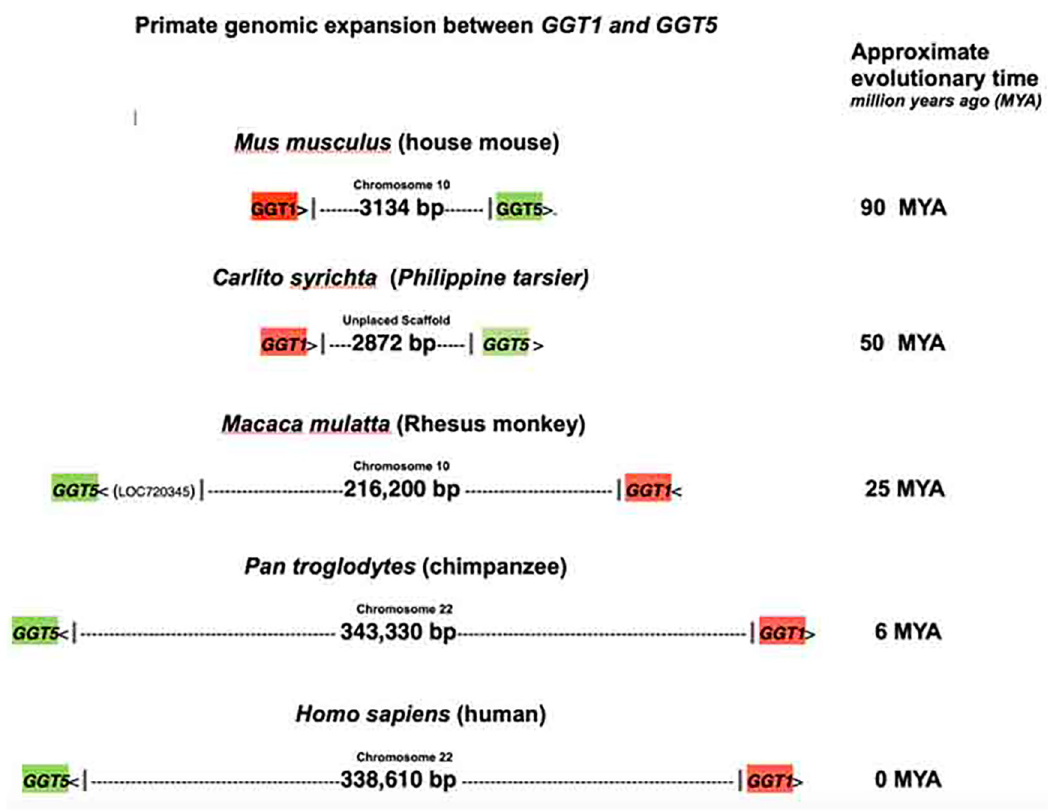
Fig 1. The spacer region/genomic lengths between GGT1 and GGT5 in various species. The house mouse and Philippine tarsier (member of ancestral primates) are in the top two drawings. The lengths of genomic regions between genes GGT1 and GGT5 in the higher primates are shown below. The chromosomal region is inverted in Rhesus and other primates. Chromosomal locations are also shown above the schematics. The approximate evolutionary time is on the right. Genomes of these species were analyzed from the NCBI data base